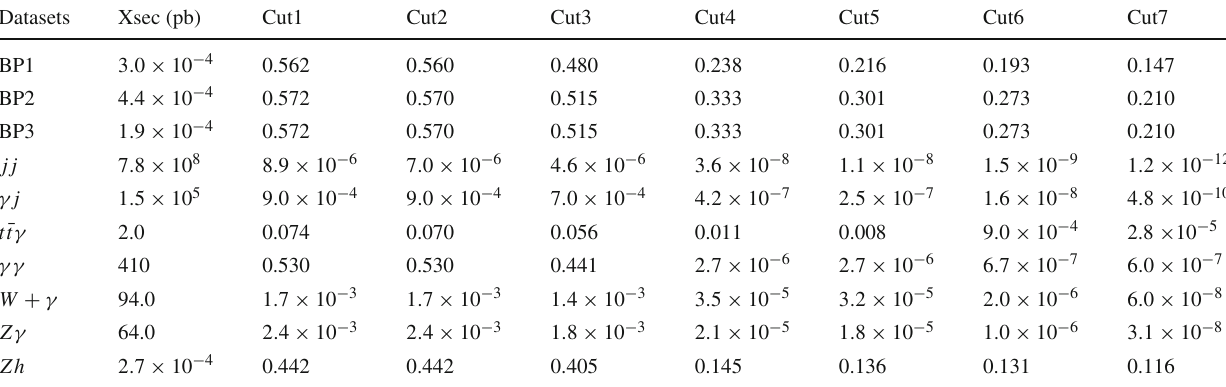
Fig. 11 Normalized distributions of (cid:15)φ between the / E T and leading (left) and sub-leading (right) photons Table 3 Signal and background efficiencies in the γγ + / E T final state after applying various cuts at 13 TeV. The cross-sections are calculated at NLO